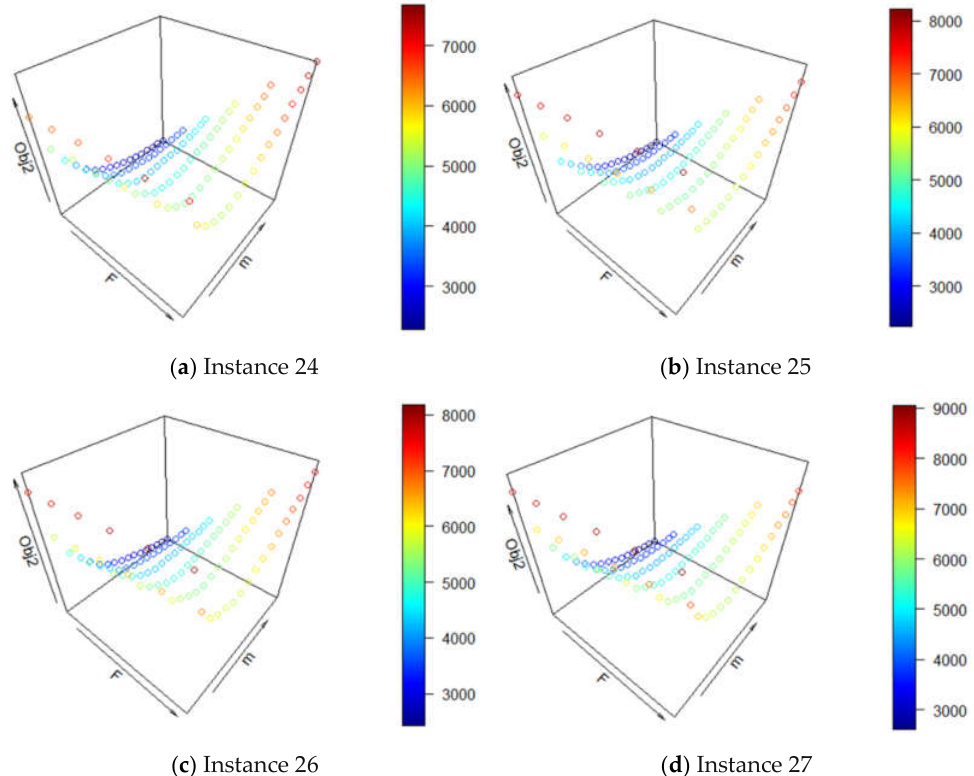
Figure 11. Cross-validation of  and F on the total cost while  = 0.20. ( a ) Instance 24; ( b ) Instance 25; ( c ) Instance 26; ( d ) Instance 27.